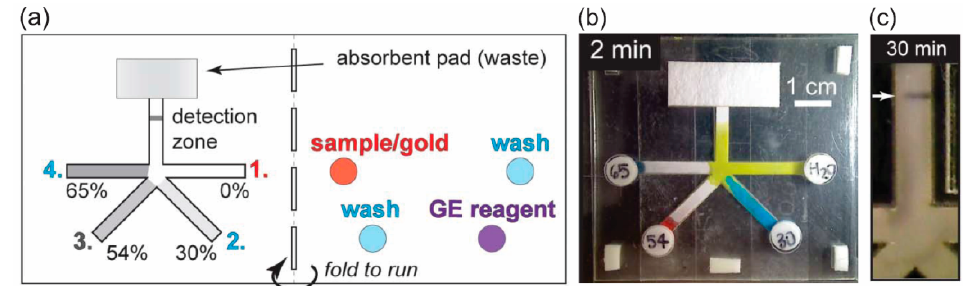
Figure 18. Automated multi-step assay by using a p-CMF device with programmable delivery of the fluid samples. ( a ) Schematic design of a p-CMF for sequential sample delivery in a multi-step assay protocol for detection of malaria. ( b ) Image of sequential sample delivery in the p-CMF device and ( c ) colorimetric detection of malaria, which was achieved by using the programmable p-CMF device. Adapted with permission from the authors of [81]. Copyright 2013 The Royal Society of Chemistry.